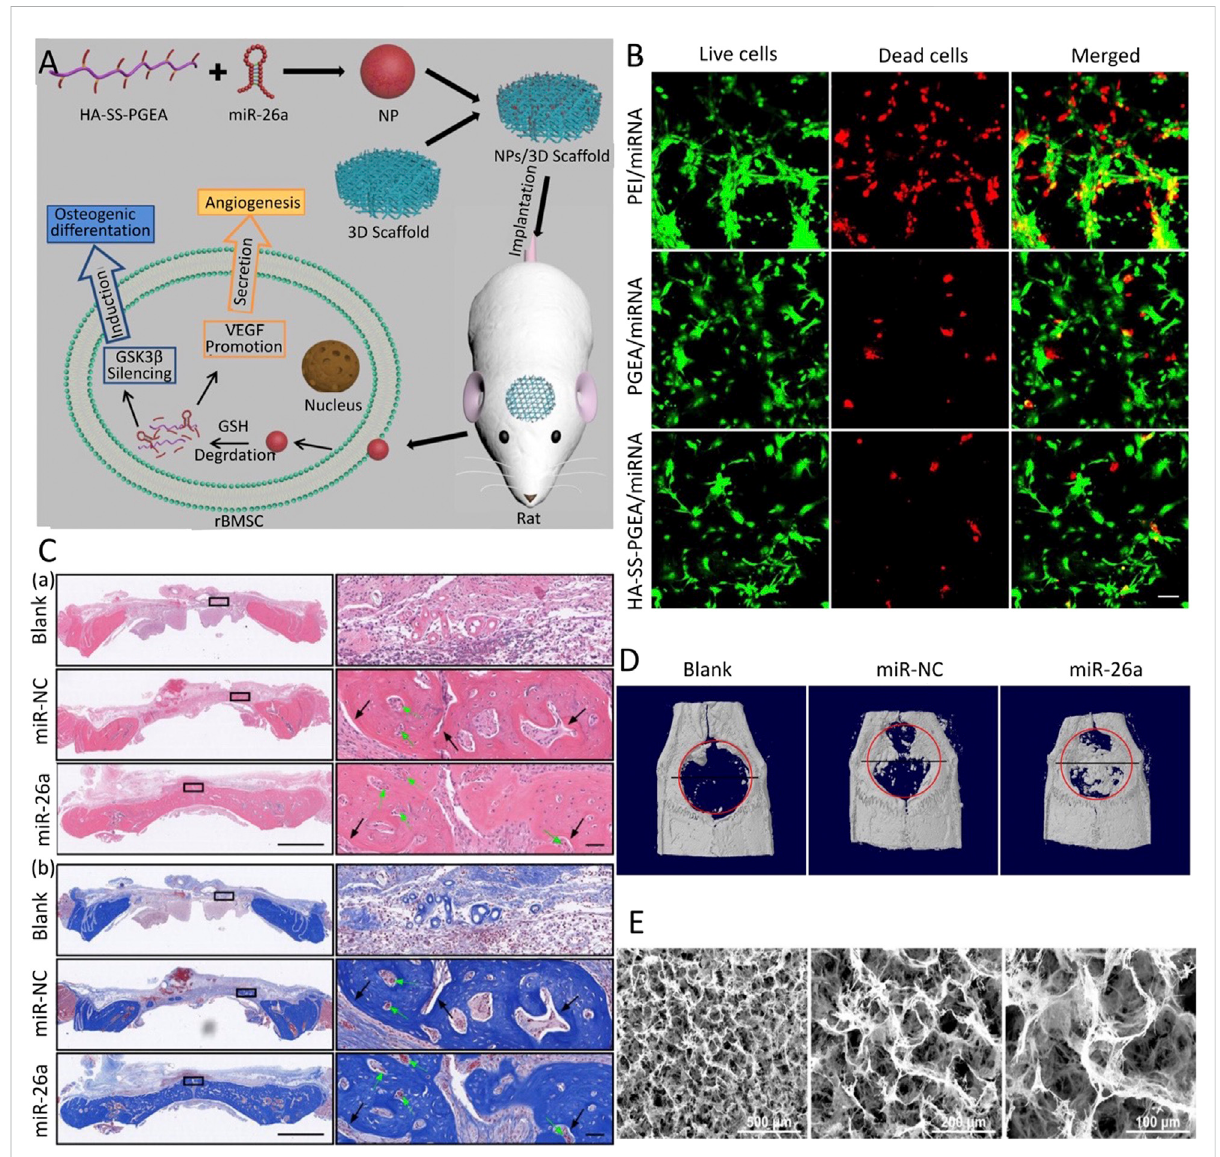
FIGURE 3 3D comb-shaped polycation (HA-SS-PGEA) nano fi ber aerogel as miR-26a carrier for bone defect healing (Li et al., 2020). (A) Schematic diagramofthecombinationofHA-SS-PGEA andmiR-26ananoparticles(NPs)andthe3Dnano fi beraerogelfor bonedefect repair. (B) CLSM images of live/dead staining mediated by various miRNA-containing NPs, including PEI, poly (glycidyl methacrylate) modi fi ed with target components, biodegradable groups, and short ethanolamine (PGEA), HA-SS-PGEA. (C) After 4 weeks of implantation, H&E staining (A) and Masson ’ s trichrome staining (MTC) (B) of rat cranial tissue wereperformed. (D) Representative planar X-ray fi lmsafter 4weeks ofimplantation. (E) SEM images of 3D mixed nano fi ber aerogels. (blank, without 3D aerogel or NPs; miR-NC, negative control; CLSM, confocal laser scanning microscope;